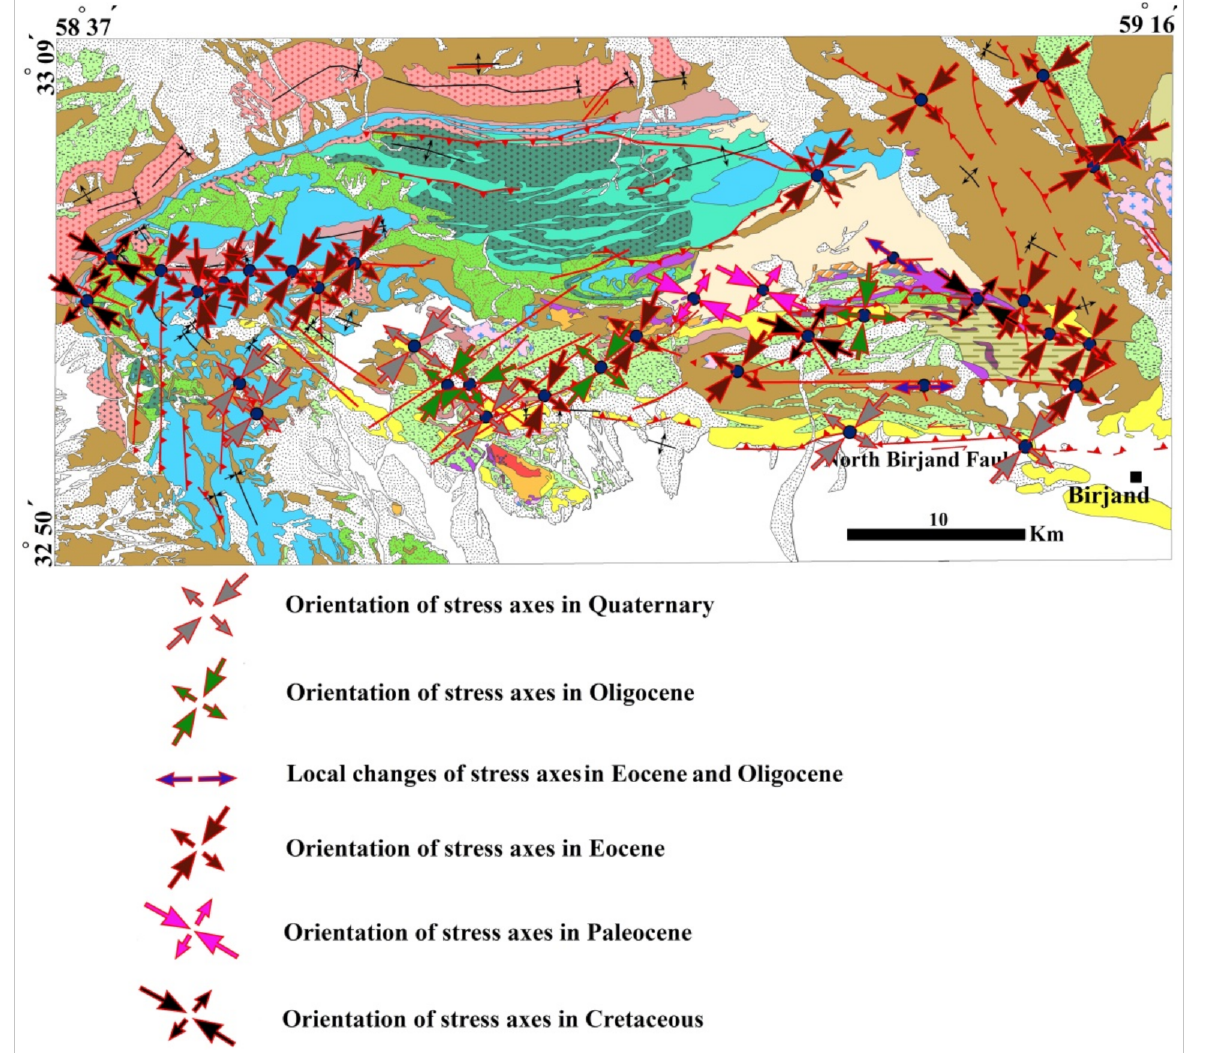
Figure 12. Directions of main stress axes in the study area from the late Cretaceous to